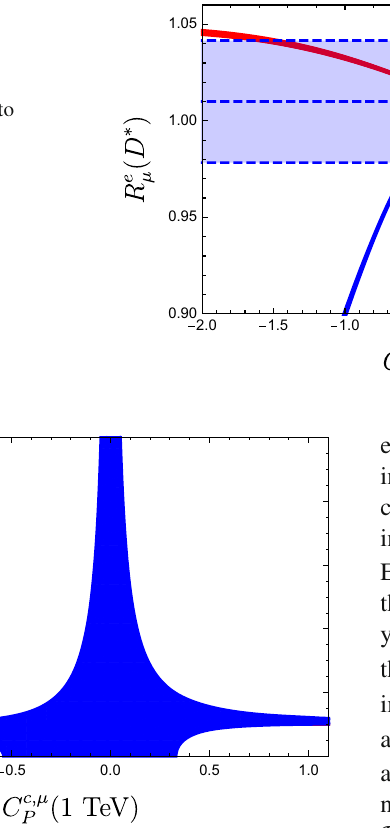
Fig. 10 Constraints on the ,μ C c